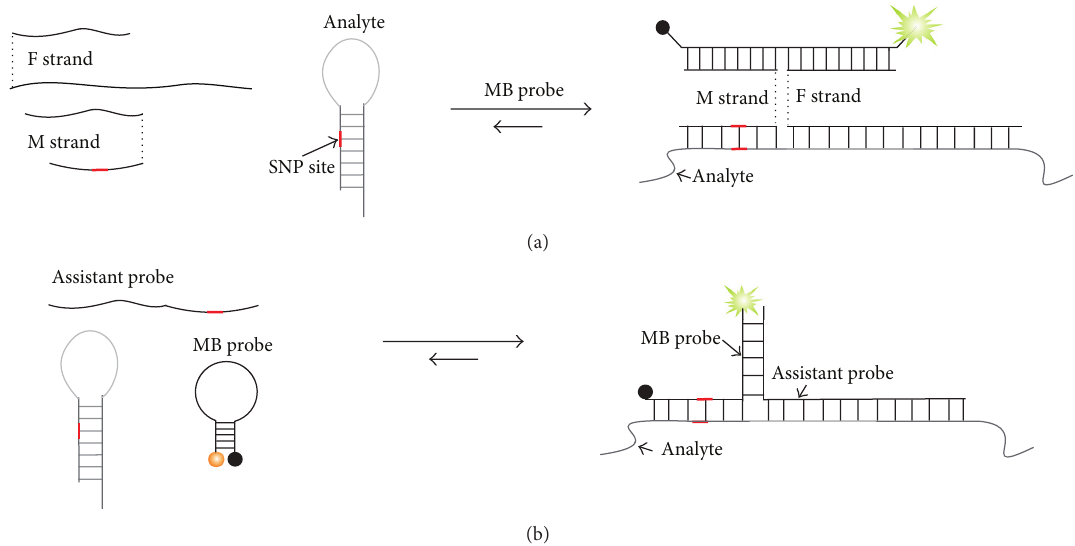
F 8: Analysis of structured nucleic acids using the helper DNA strands. (a) MB-based tricomponent sensor. F strand uses long analyte- binding arm to unwind the analyte’s secondary structure. M strand binds to the opened analyte fragment only if an SNP site matches the analyte-binding arm of M strand. e two adaptor strands joint by the analyte open MB probe, thus producing high �uorescence. (b) �- shaped junction probes. An assistant probe tightly binds and unwinds the analyte and together with MB probe forms �uorescent three-way junction complex. MB probe is partially complementary to the SNP site.